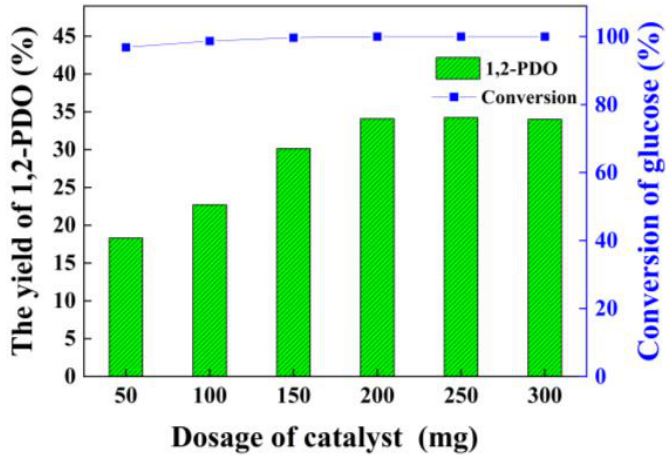
Figure 4. The effect of catalyst dosage on glucose hydrogenolysis into 1,2-PDO. Reaction condition: Pt loading (3.0 wt%), glucose (11.25 mg/mL, 10 mL) and H 2 (initial 6 MPa) at 200 °C for 3 h.